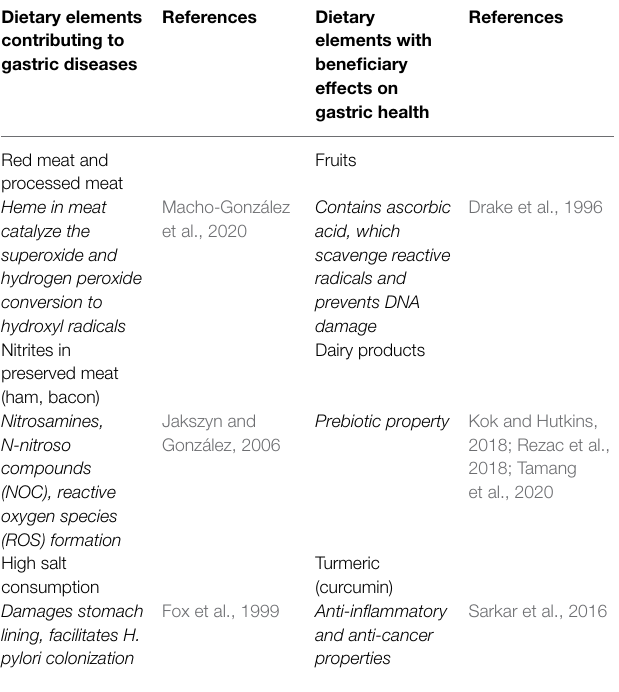
TABLE 5 | Impact of dietary elements on gastric